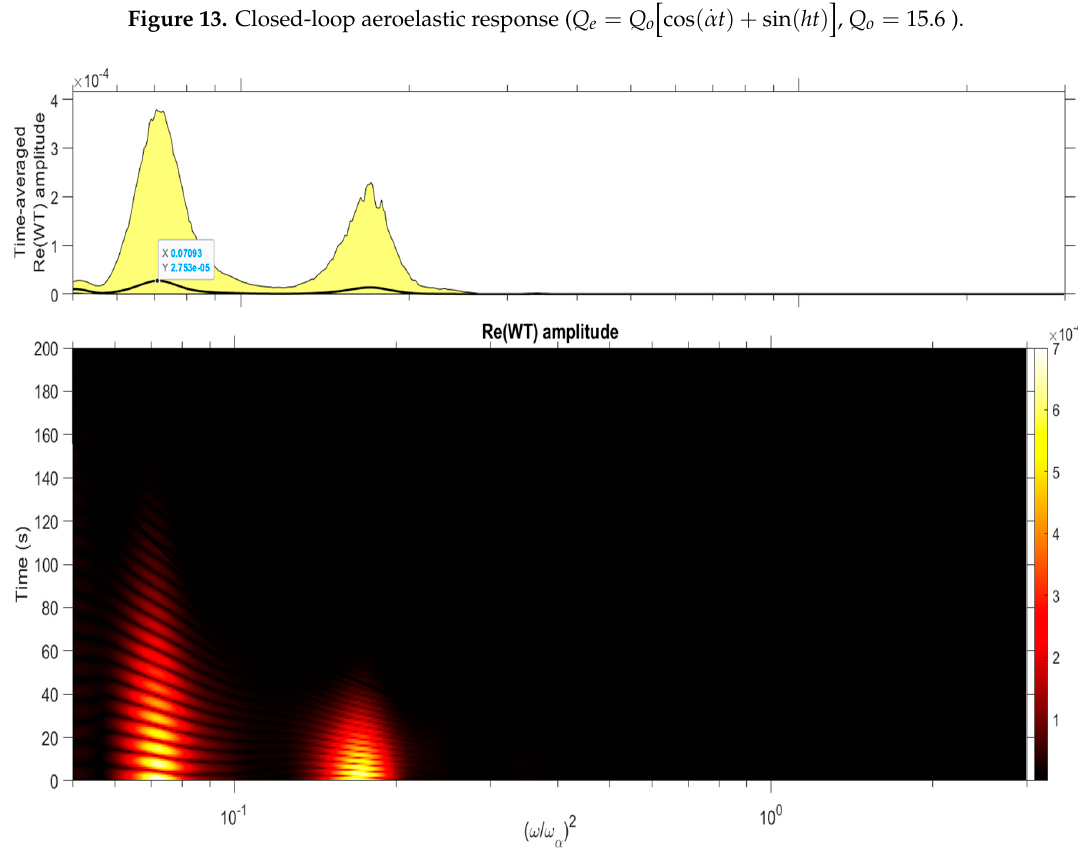
Figure 14. Time–frequency analysis: Q e = 15.6 [ sin ( ht )] Figure 14. Time–frequency analysis: 𝑄 (cid:3032) = 15.6(cid:4670)sin(ℎ 𝑡)(cid:4671) . Figure 14. Time–frequency analysis: 𝑄 (cid:3032) = 15.6(cid:4670)sin(ℎ 𝑡)(cid:4671) .